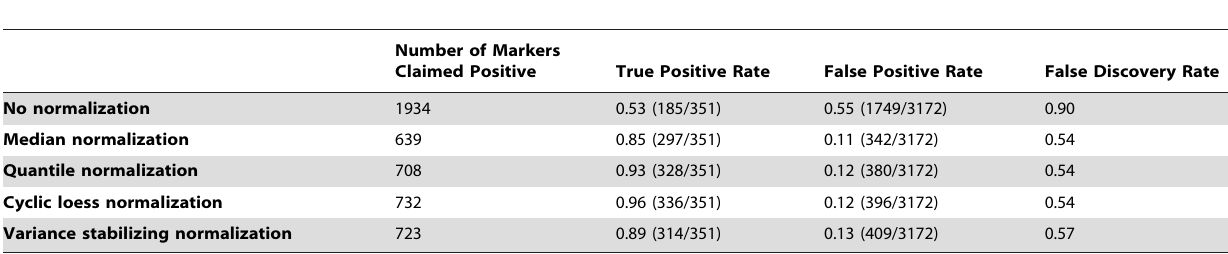
Table 1. Results of differential expression analysis of the test data before and after normalization, in comparison with the benchmark data.